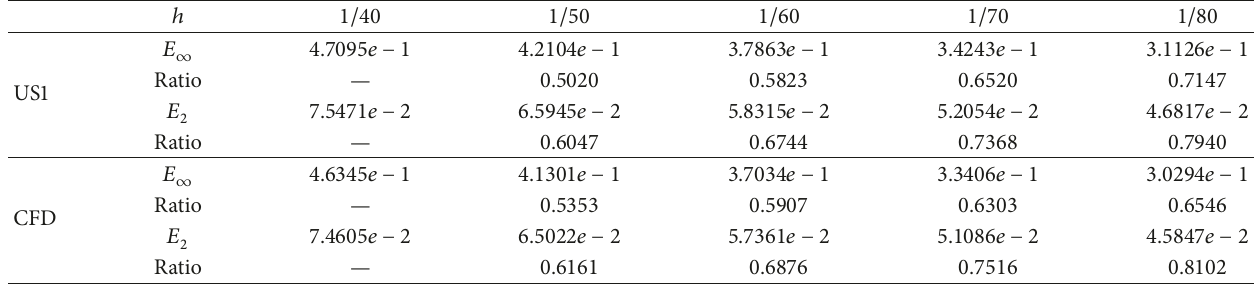
Table 3: Errors and ratios in space of the characteristic finite difference scheme (CFD) and the first-order upwind scheme (US1) using small time step of 𝑁 𝑡 = 400